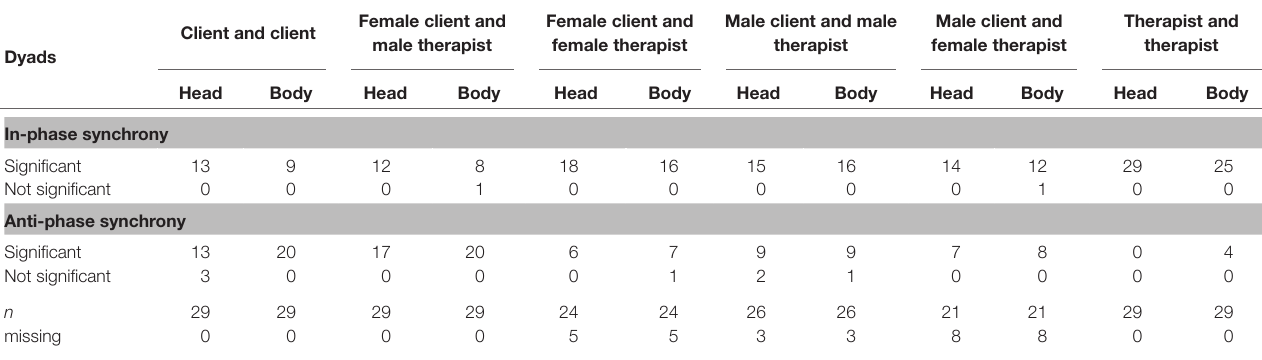
TABLE 4 | The amount of significant and not significant nonverbal synchrony per